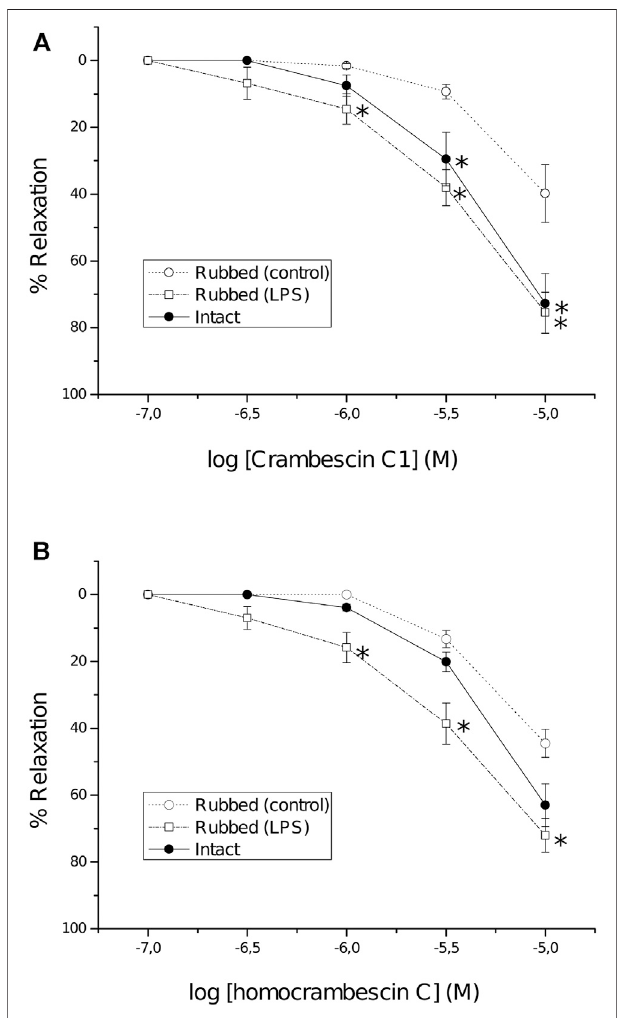
FIGURE 5 | Concentration-response curves of CC (A) and HCC (B) in intact (full symbols) and rubbed (open symbols) rings of thoracic aorta pre- contracted with phenylephrine (1 µM). Before obtaining the concentration response curves, some rubbed rings were incubated with lipopolysaccharide (10 μ g/ml) for 5 h (LPS). Each point represents the mean response of at least four aortic rings; S.E.M. is represented by vertical lines. * p < 0.05 vs. control rubbed